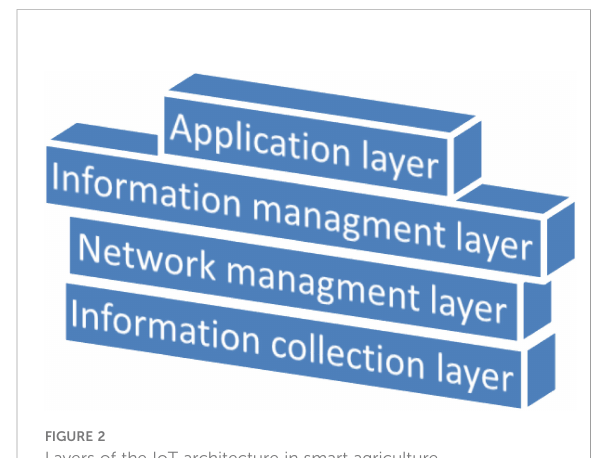
FIGURE 2 Layers of the IoT architecture in smart